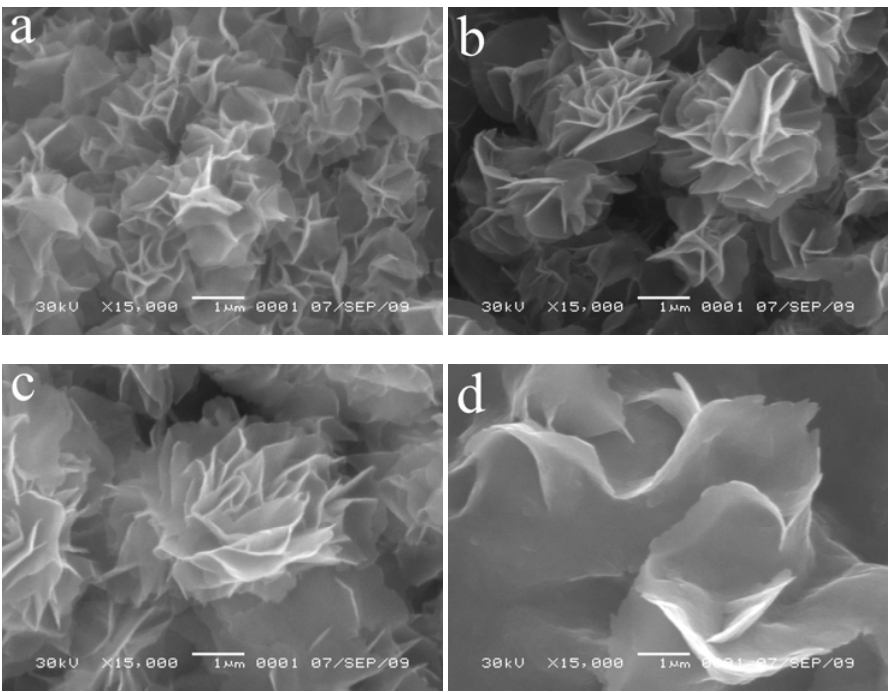
Figure 3. SEM images of the intermediate products obtained at various